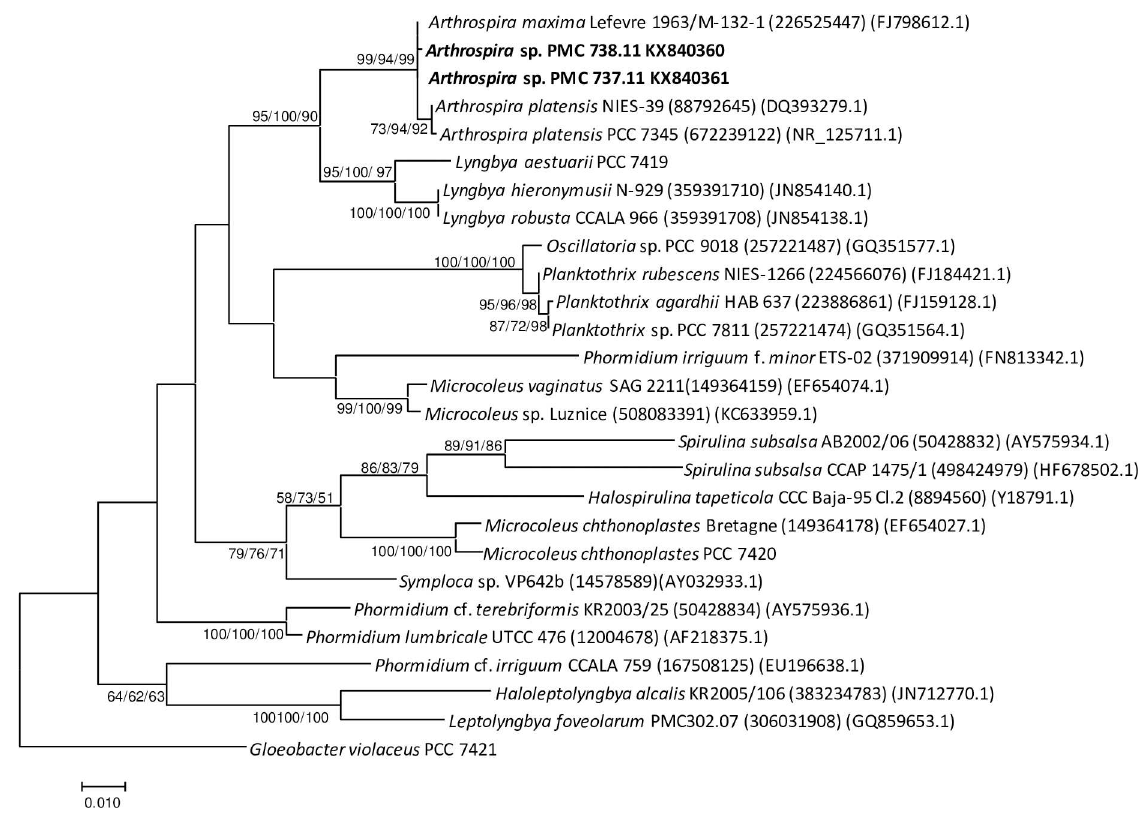
identification as Arthrospira using the morphological approach was confirmed by 16S rRNA gene sequence analyses on the two cultivated isolates (PMC 737.11 and 738.11). Molecular anal- yses revealed that this cyanobacterium shared 99% sequence identity with Arthrospira platensis and A . maxima (Fig 6). Less dominant taxa were represented by several morphotypes of thin fil- amentous cyanobacteria ( < 3μm) belonging to the family Leptolyngbyaceae (Fig 5A and 5C). Together with these filamentous forms, numerous round cells were visible using microscopy,